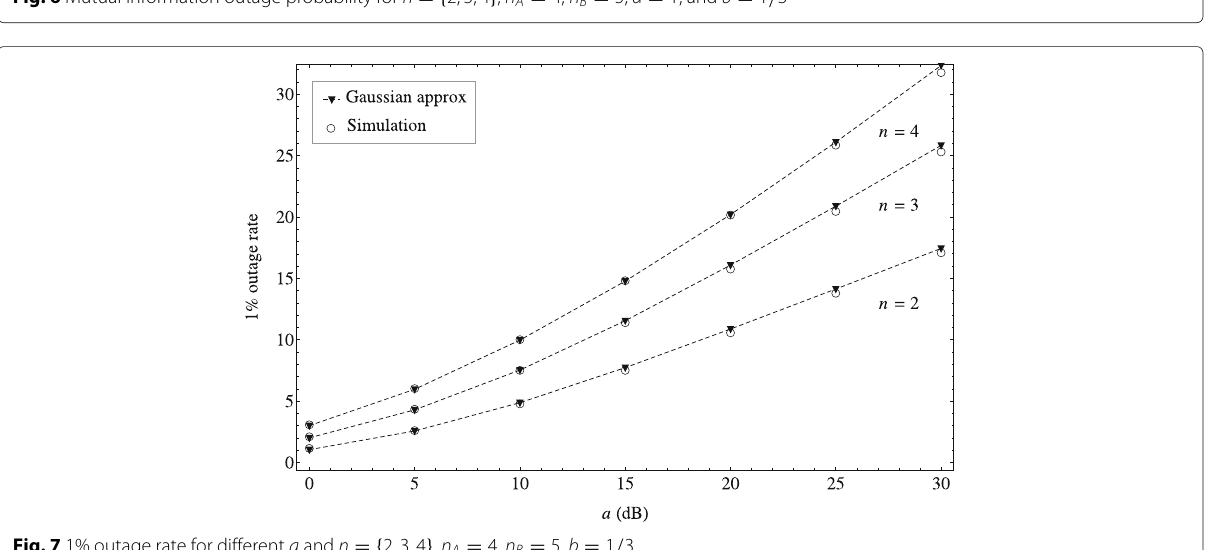
Fig. 7 1% outage rate for different a and n = { 2,3,4 } , n A = 4, n B = 5, b = 1 /